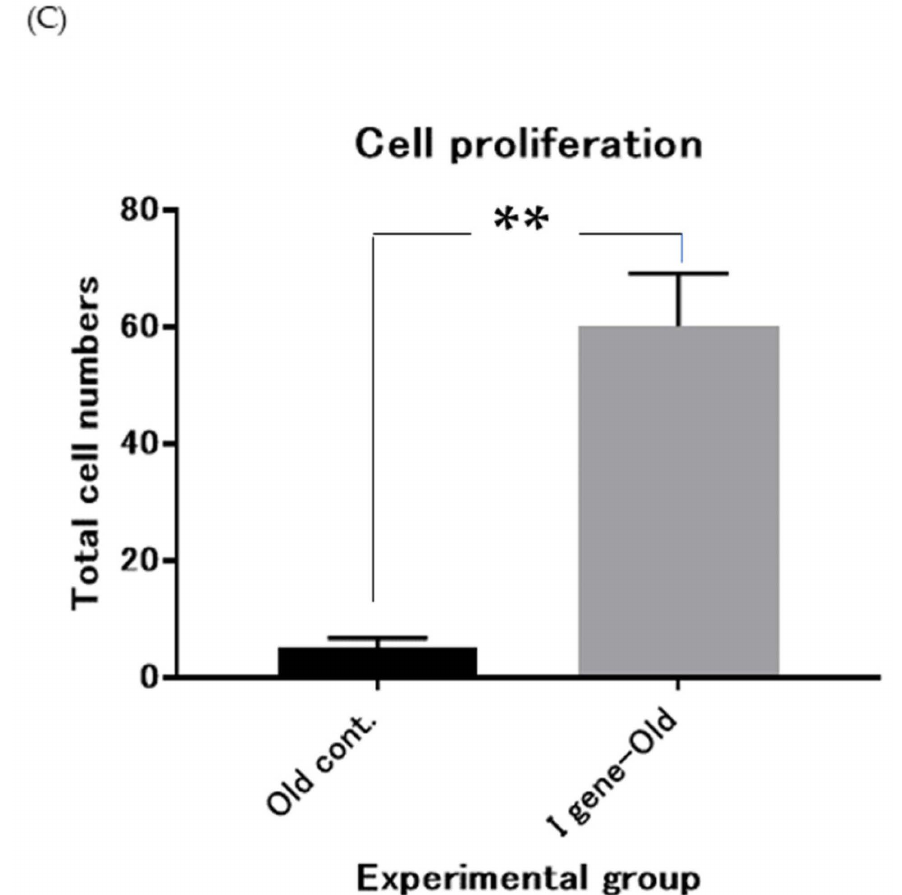
Figure 6. Immaturin-imaging in the life cycle phase transitions and rejuvenescence. ( A ) Confocal images of immature cells at about 20 fissions after conjugation, photographed using Nikon A1. Representative cells show many condensed green bodies (GB) in the macronucleus (an arrowhead indicates one typical GB). Scale bars, 20 µ m. ( B ) The early stage of immaturity at five fissions after conjugation. The middle stage of immaturity is at about 15 fissions after conjugation. Late-stage immaturity is at about 40 fissions after conjugation. The mature stage is at about 100 fissions after conjugation. The senescent stage is at about 1000 fissions after conjugation. Senescent cells at about 1000 fissions were transformed by the microinjection of the immaturin gene. The ‘yes’ or ‘no’ attached to each stage of the picture visualized with an anti-immaturin antibody indicates the presence or absence of fluorescence in the ventral cilia, respectively. Scale bars, 20 µ m. ( C ) The graph shows the rejuvenating effect of immaturin gene transformation on the proliferative capacity of senescent cells. Single cells were isolated in a capillary with the fresh culture medium in each experimental group and incubated for four days at 25 ◦ C. Old cont. indicates control senescent cells. I gene-Old indicates senescent cells transformed by the immaturin gene. Data represent average total cell numbers in the capillary culture ± SD (n = 6). Student’s t-test: ** p <